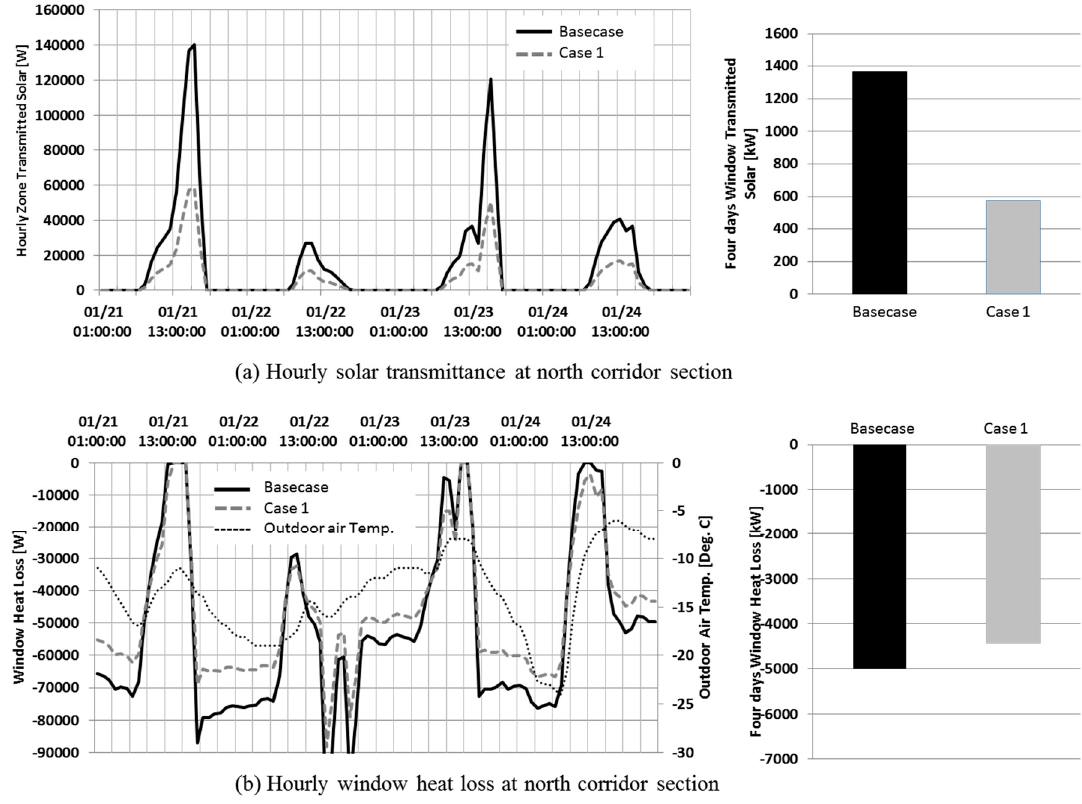
Figure 8. Hourly window thermal ‐ optical characteristics between Base case and Case 1.